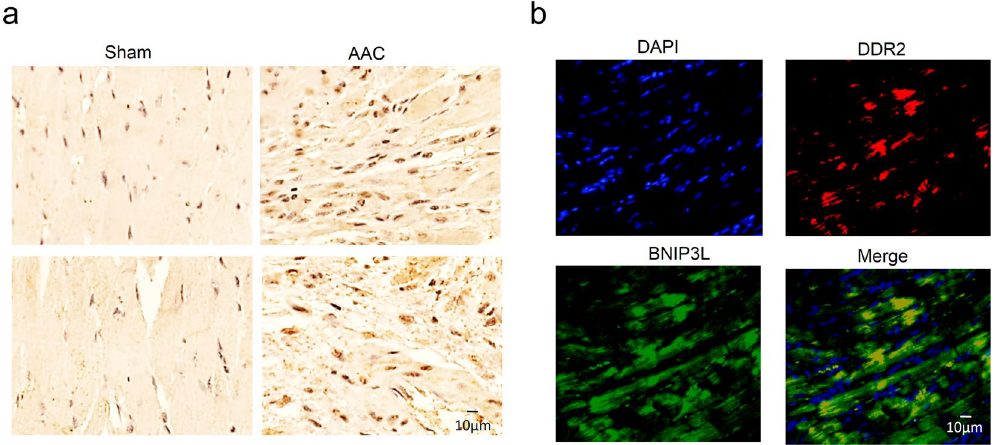
Figure 2. BNIP3L is up-regulated in CFs during pressure overload-induced cardiac remodeling. ( a ) Immunohistochemistry showing the cellular distribution of BNIP3L. ( b ) Immunofluorescence showing the co- localization of BNIP3L and DDR2.